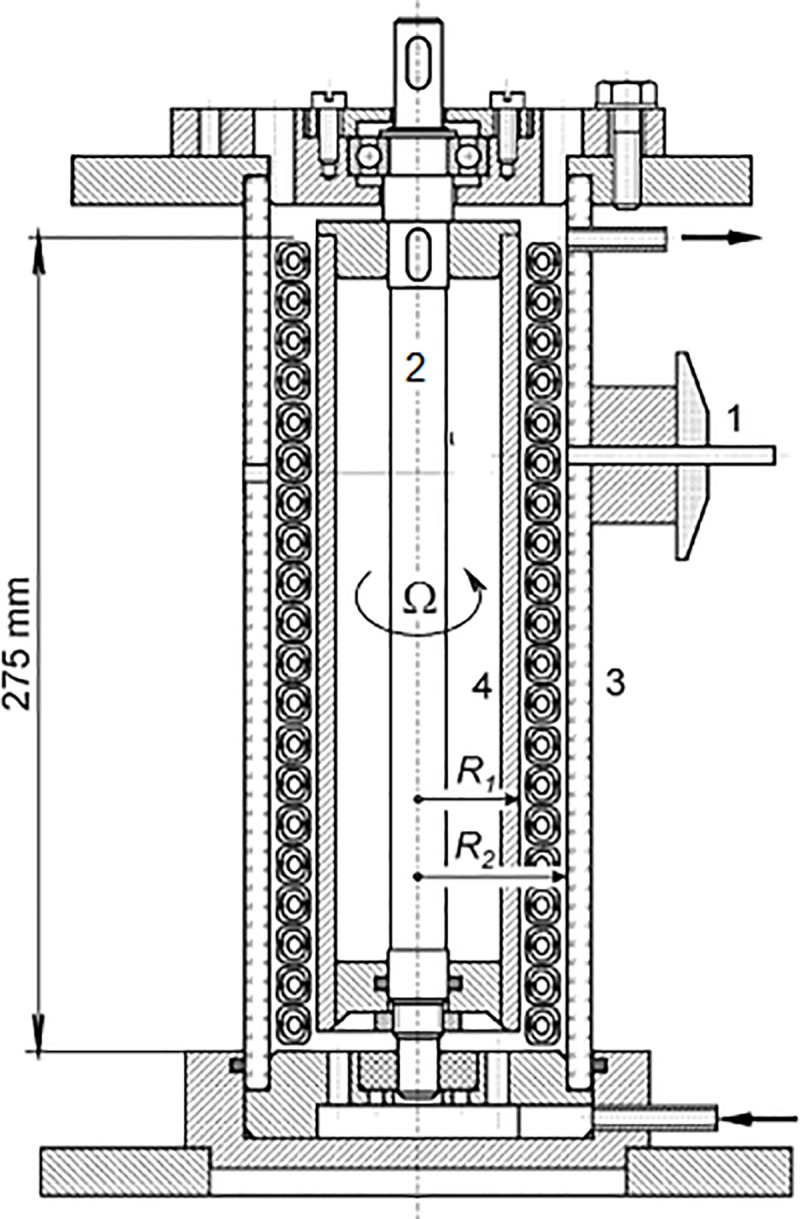
Experimental set-up with Taylor vortices.(1) three-segment electrodiffusion probe, (2) shaft, (3) outer cylinder, (4) inner cylinder. The arrows represent flow input and output.